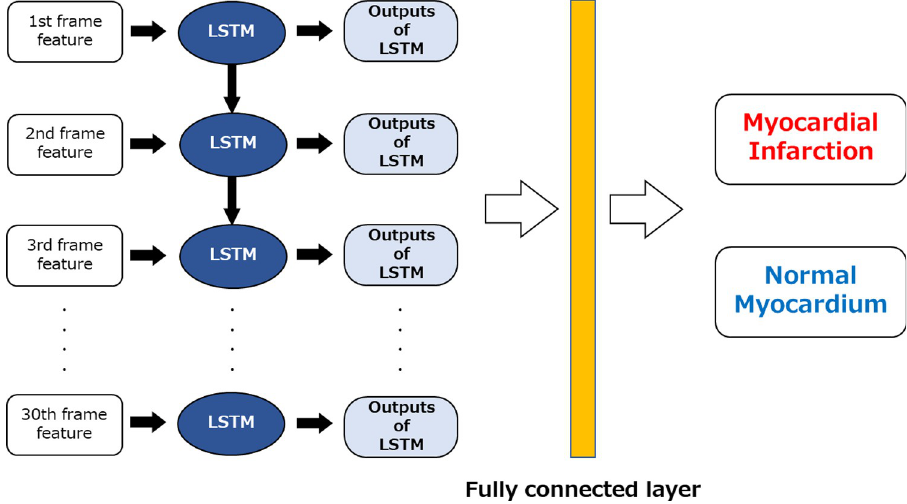
Fig 9. Classification of myocardial infarction and normal myocardium cases. LSTM, long short-term memory. Features from 1 to 30 frames were input to each LSTM, and the classification was performed using the softmax function based on the LSTM